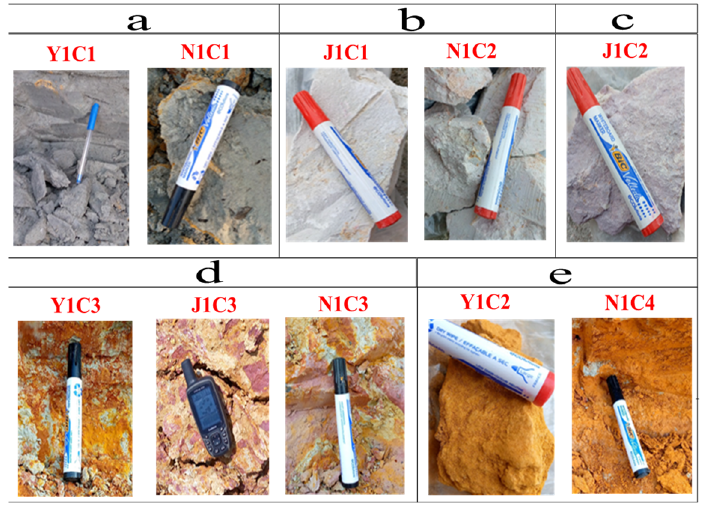
Figure 3. Photos of the different facies analyzed in the eastern part of the Douala sub-basin: ( a ) dark gray clay (Y1C1, N1C1); ( b ) light gray clay (J1C1, N1C2); ( c ) purple clay (J1C2); ( d ) multicolored clay (Y1C3, J1C3, N1C3); and ( e ) yellow clay (Y1C2, N1C4).